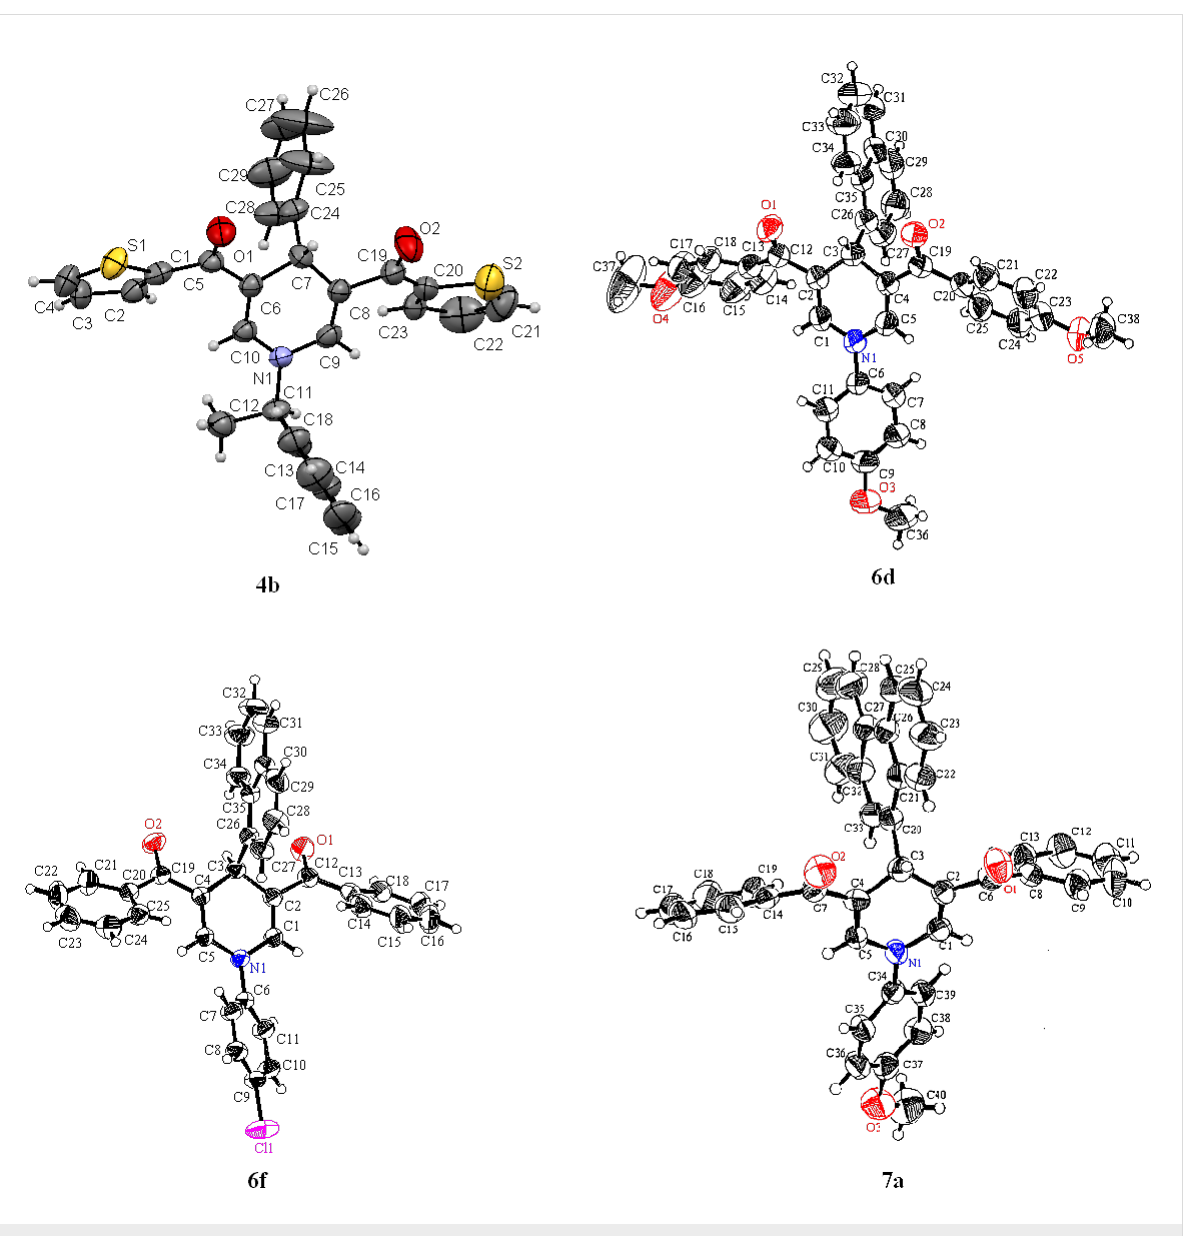
Figure 1: ORTEP of compounds 4b , 6d , 6f and 7a .